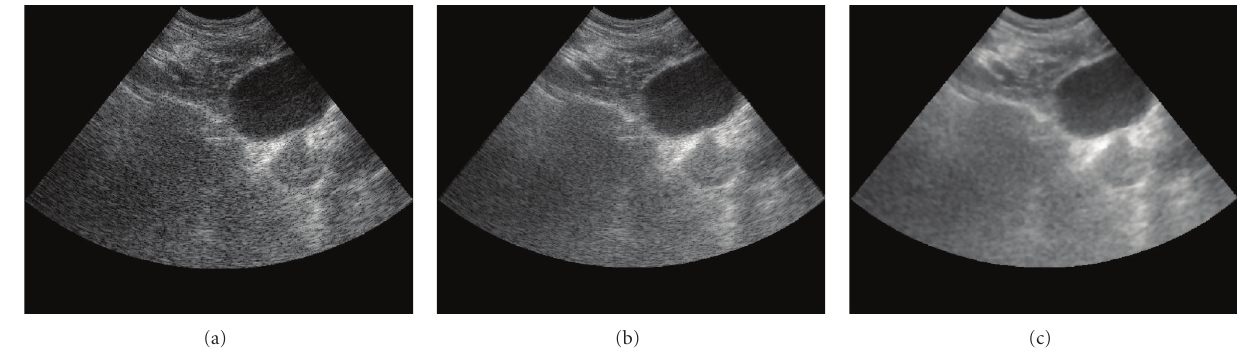
Figure 5: (a) A slice of clinical US B-scan of prostate, (b) a slice of bilinear reconstruction, and (c) a slice of MMSE reconstruction.